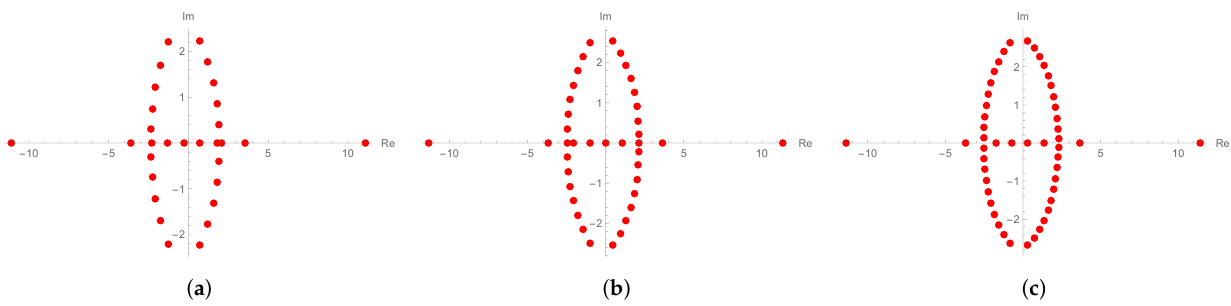
Figure 2. The positions of approximation roots of C S n ,0.9,0.8 ( x ,2 ) for n = 30,40,50. ( a ) C S 30,0.9,0.8 ( x ,2 ) ; ( b ) C S 40,0.9,0.8 ( x ,2 ) ; ( c ) C S 50,0.9,0.8 ( x ,2 ) .